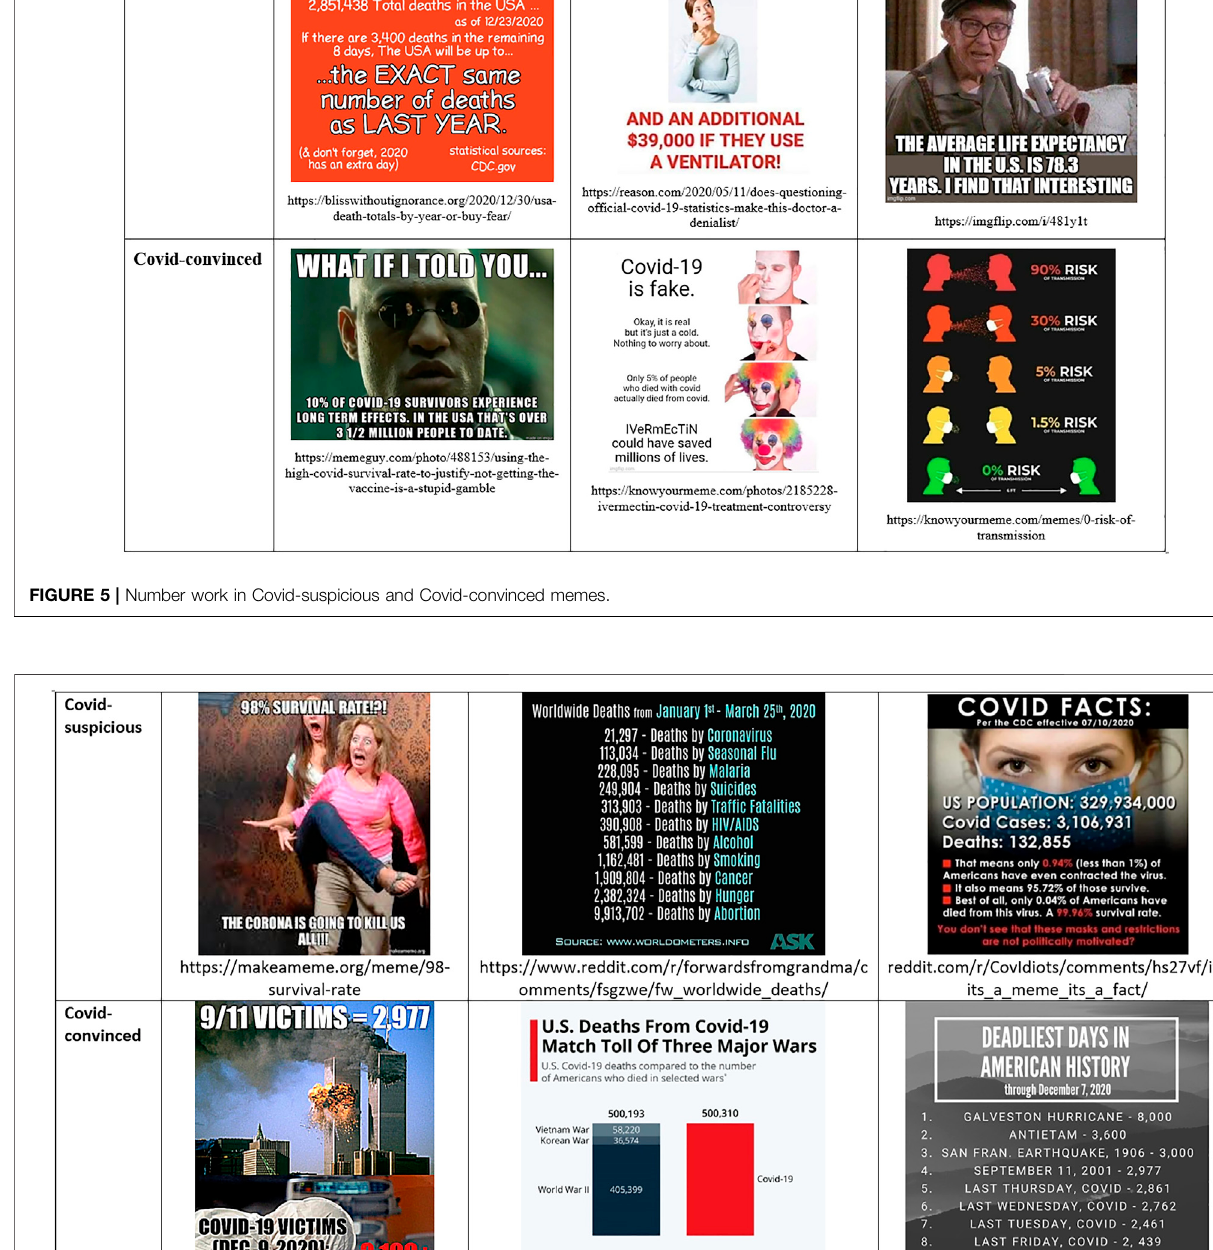
Frontiers in Sociology |